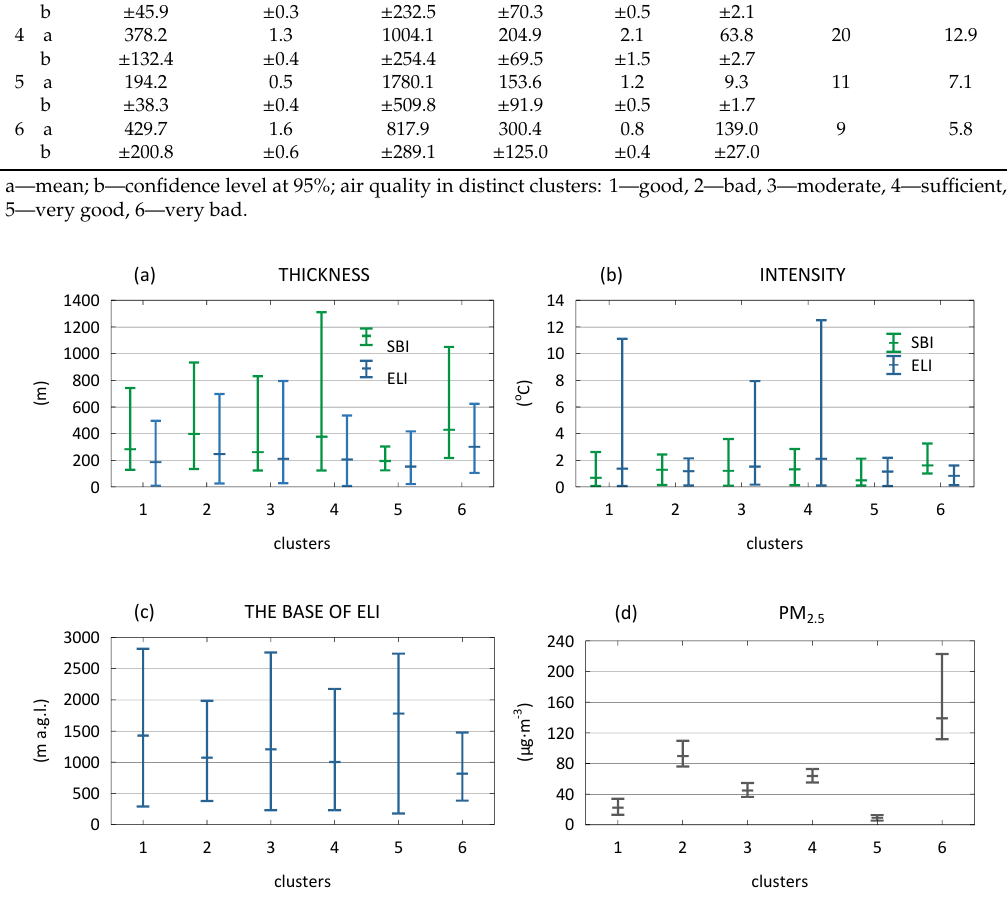
Figure 8. Basic characteristics (mean and min-max) of TI layers ( a – c ) and PM 2.5 ( d ) in selected clusters. Air quality in distinct clusters: 1—good, 2—bad, 3—moderate, 4—su ffi cient, 5—very good, 6—very